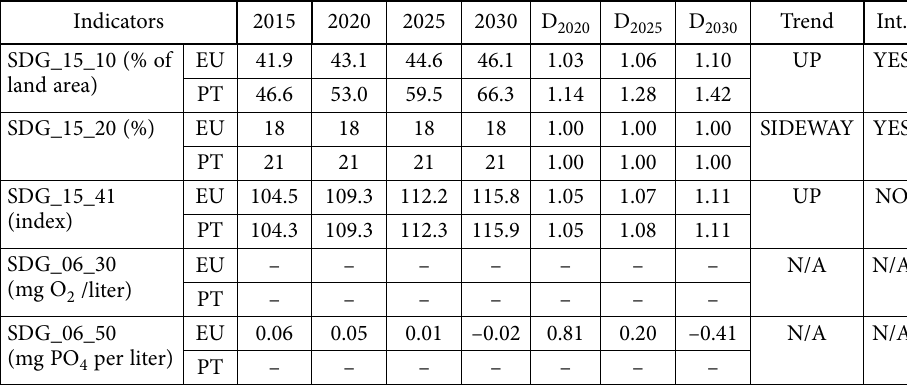
Table 16. SDG 15 – Life on